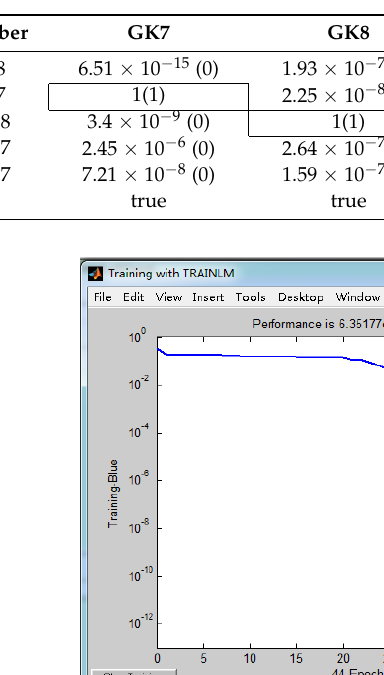
Table 6. The prediction result of networks when two elements are damaged (the target result of networks in the parenthesis).